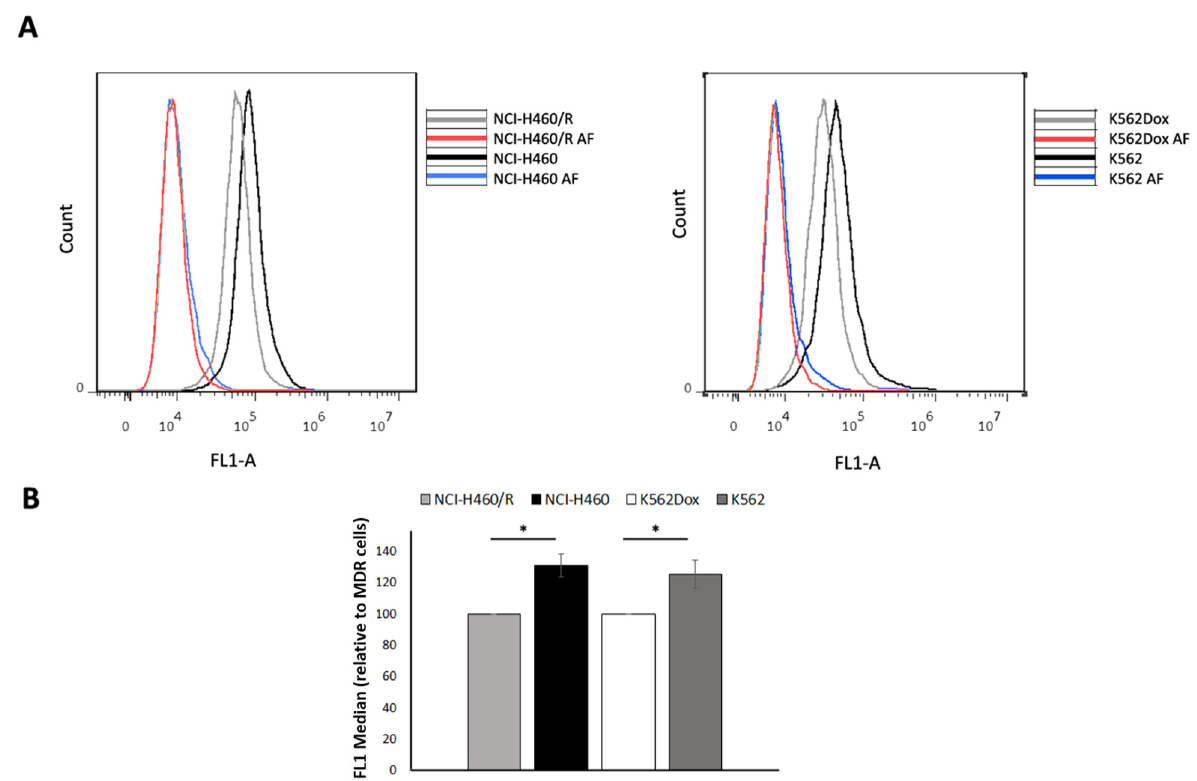
Figure 3. Comparison of the levels of fluid-phase endocytosis of dextran between drug-sensitive (NCI-H460, K562) and MDR (NCI-H460/R, K562Dox) counterpart cells, analyzed by flow cytometry. ( A ) Histograms representative of three independent experiments; ( B ) relative FL1 median of NCI-H460/R vs. NCI-H460 cells and of K562Dox vs. K562 cells. Data represent the mean ± SEM from three independent experiments. * p ≤ 0.05. Incubation of cells at 4 °C was performed as a negative control (ratio of FL1 median between DS vs. MDR cells: 97 and 106% for the NSCLC cells (NCI-H460/NCI-H460/R pair) and CML cells (K562/K562Dox pair), respectively). AF—autofluorescence.